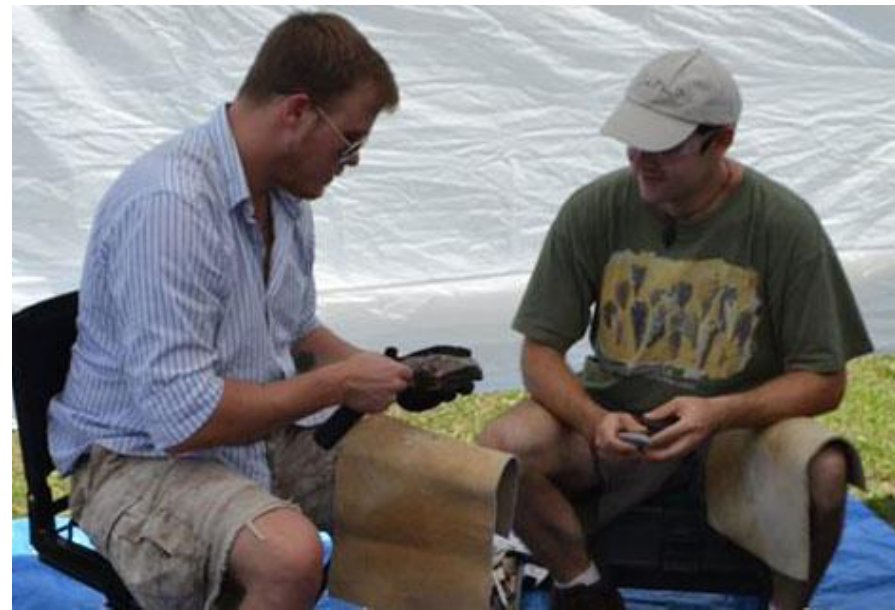
Figure 1. Michael Miller (right) teaching handaxe manufacture. (Photo by Outdoors Without Limits.)